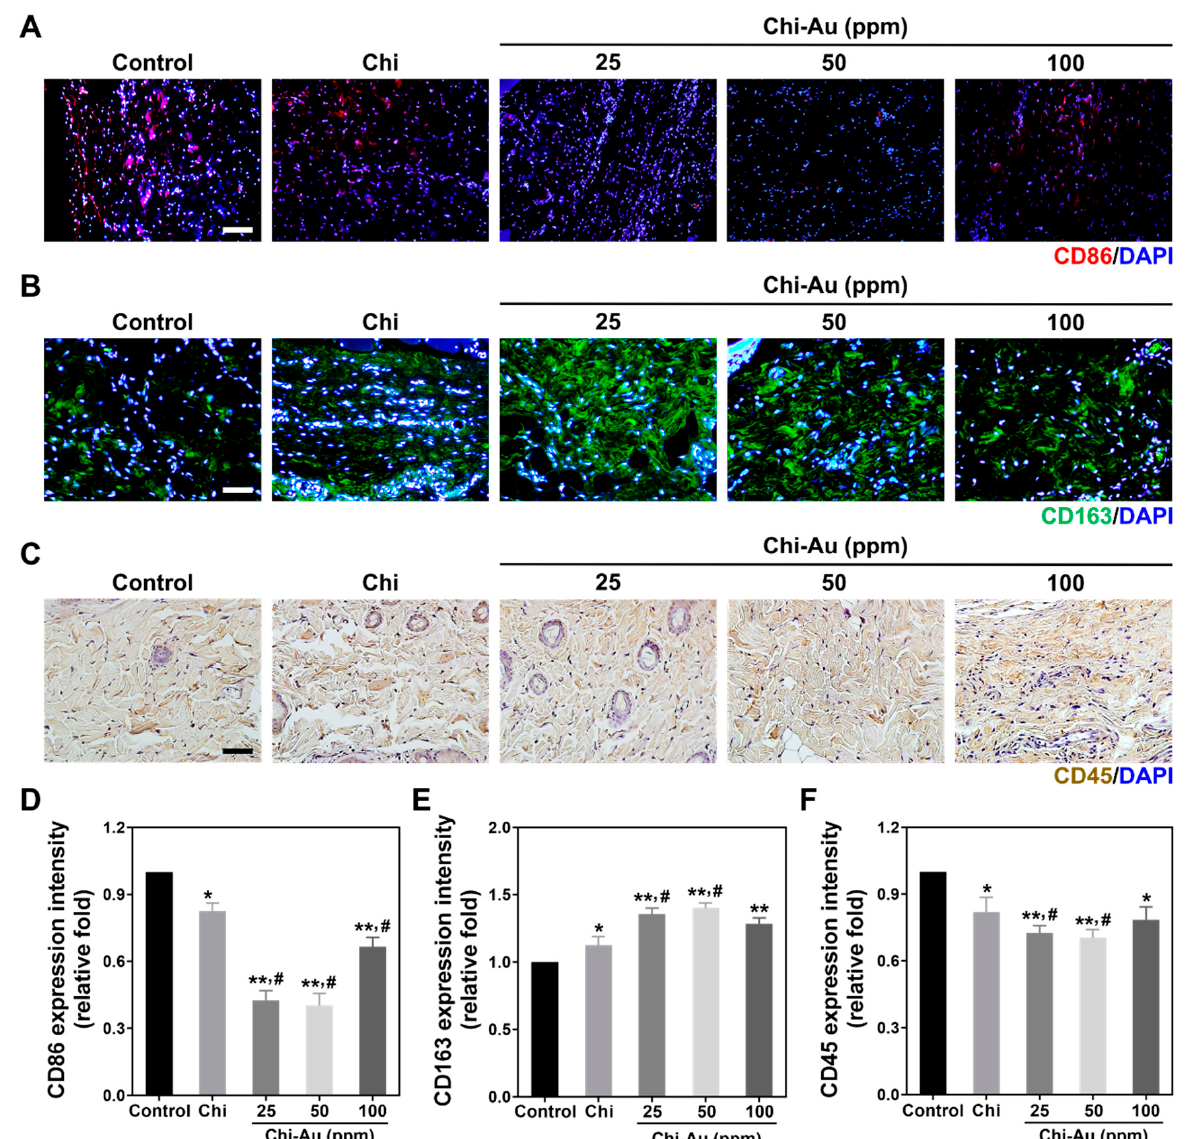
Figure 8. Immunohistochemical (IHC) staining for the investigation of anti-inflammatory capacities after subcutaneous implantation for 4 weeks. ( A , B ) The expressions of CD86 (M1 polarization, red color) and CD163 (M2 polarization, green color) are shown. ( C ) The expression of CD45, which indicates leukocyte filtration, was observed using DAB staining. ( D , E ) The expressions of CD86 and CD163 were semi-quantified. Chi combined with 50 ppm of Au stimulated the lowest CD86 expression. In contrast, the expression of CD163 was remarkably greater with Chi–Au 50 ppm treatment. ( F ) The CD45 expression was quantified. Based on the result, Chi–Au 50 ppm induced the lowest CD45 expression. The results elucidate that Chi with 50 ppm of Au exhibited better biocompatibility when compared with the other tested nanocomposites. Scale bar was 100 µ m. Results are presented as mean ± SD ( n = 3). * p < 0.05, ** p < 0.01: compared with the control (TCPS); # p < 0.05: compared with the Chi group.